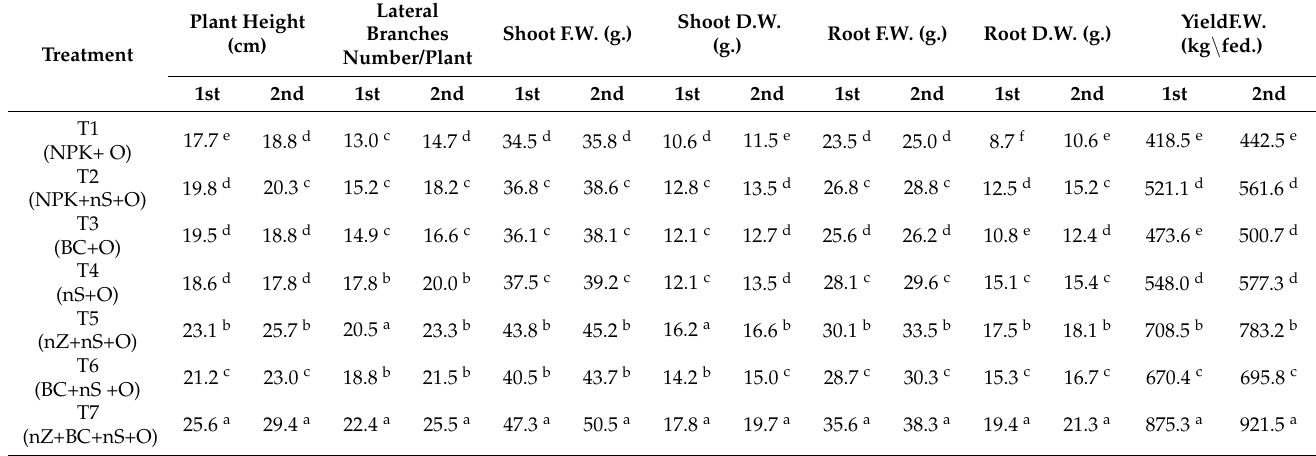
Table 5. Effect of nanoparticles on growth parameters and thymeyield during 2020 and 2021 growing